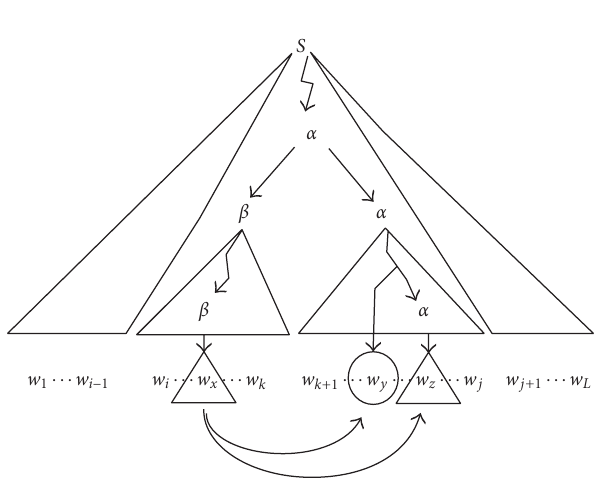
Figure 4: Phrase structure tree based on dependency